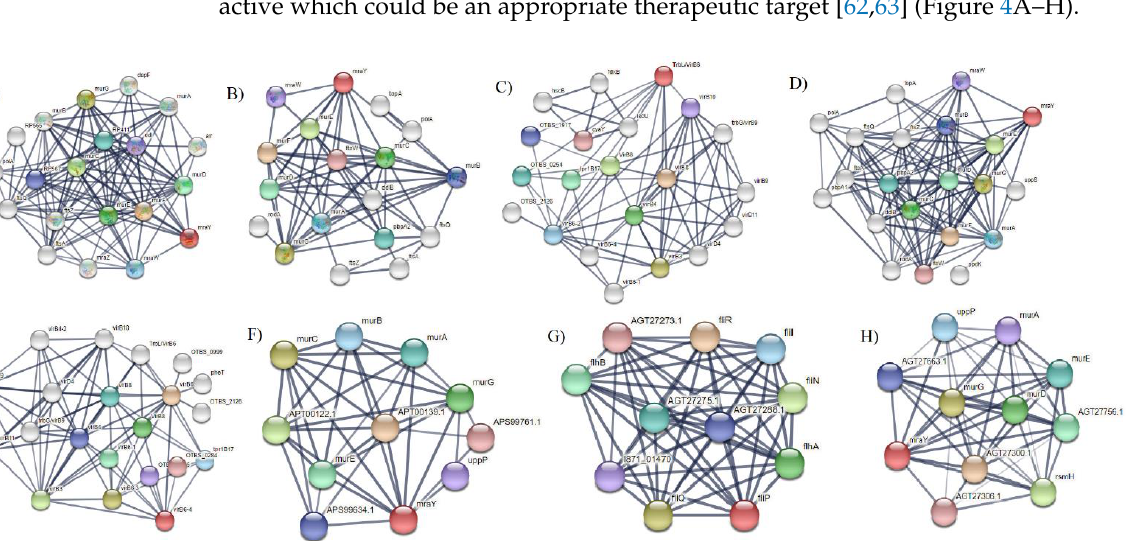
Figure 4. Protein–protein interaction of protein using string database. Nodes of the network represent protein while protein–protein interaction are presented by edges. The red colors show the query proteins and first shell of interaction, and the white nodes show the second level of interaction. Empty nodes show proteins of unknown 3D structure, and filled nodes show proteins of known or predicted 3D structure. ( A ) phospho-N-acetylmuramoyl-pentapeptide-transferase membrane proteins ( Rickettsia prowazekii str. Madrid E). ( B ) UDP-N-acetylenolpyruvoylglucosamine reductase membrane proteins of Orientia tsutsugamushi str. Boryong. ( C ) conjugal transfer protein membrane proteins of O. tsutsugamushi str. Boryong. ( D ) Phospho-N-acetylmuramoyl-pentapeptide-transferase membrane proteins of O. tsutsugamushi str. Boryong. ( E ) Type IV secretion system protein membrane proteins of O. tsutsugamushi str. Boryong. ( F ) phospho-N-acetylmuramoyl-pentapeptide-transferase of Borrelia miyamotoi , ( G ) flagellar type III secretion system pore protein FliP of B. miyamotoi , and ( H ) phospho-N-acetylmuramoyl-pentapeptide-transferase of Borreliella mayonii